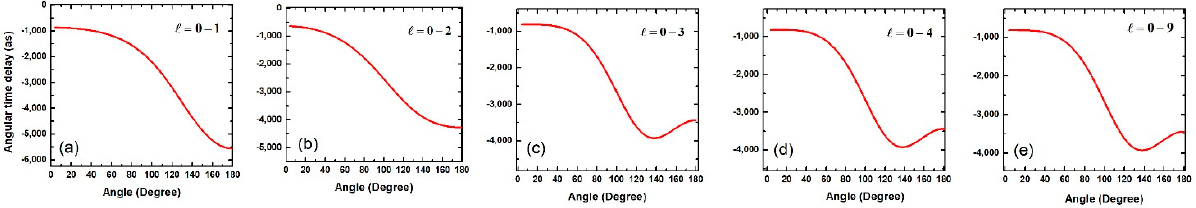
Figure 13. Angular time delay at the energy E 1 = 0.0050 a.u. plotted for different partial wave combinations ( a ) (cid:96) = 0–1, ( b ) (cid:96) = 0–2, ( c ) (cid:96) = 0–3, ( d ) (cid:96) = 0–4 and ( e ) (cid:96) =